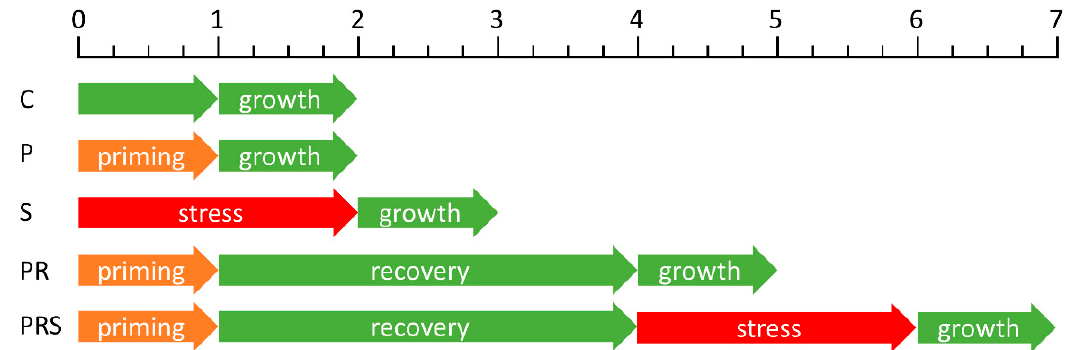
Figure 12. Diagram of heat treatments to which pollen was subjected (green: room temperature; orange: priming at 30 °C; red: stress at 35 °C). The scale at the top is the time in hours. The term “growth” indicates pollen tube germination.